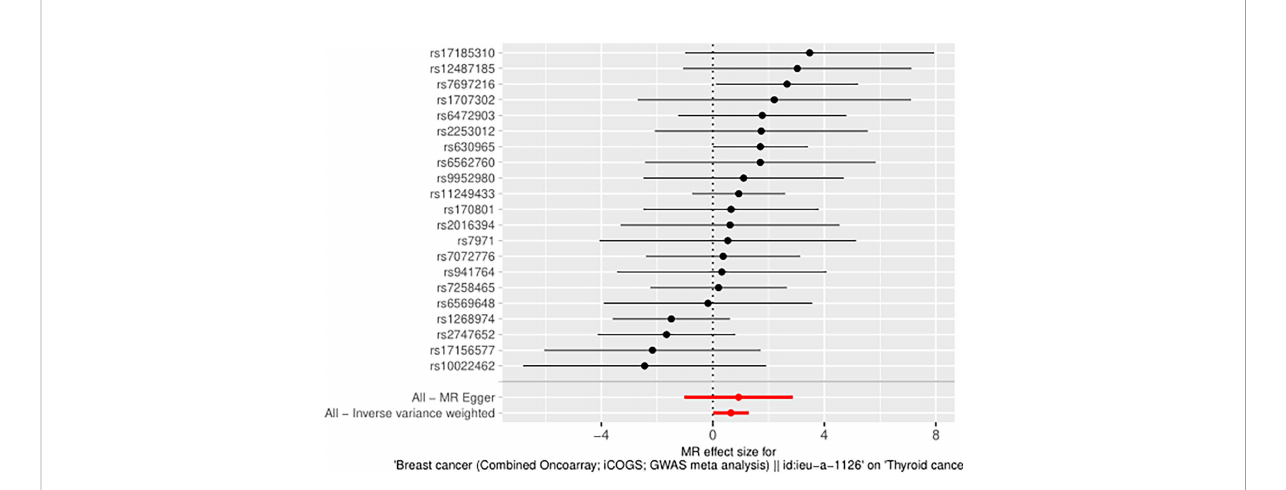
FIGURE 5 Forest diagram of instrumental variable (BN ! TN).